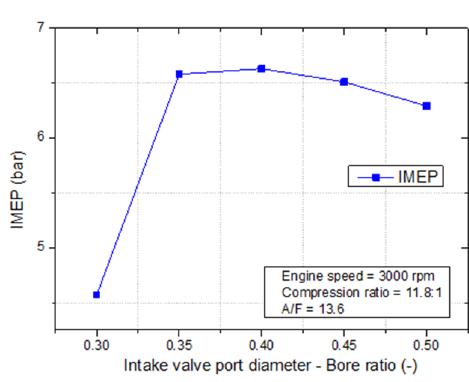
Figure 9. IMEP versus IPD/B.